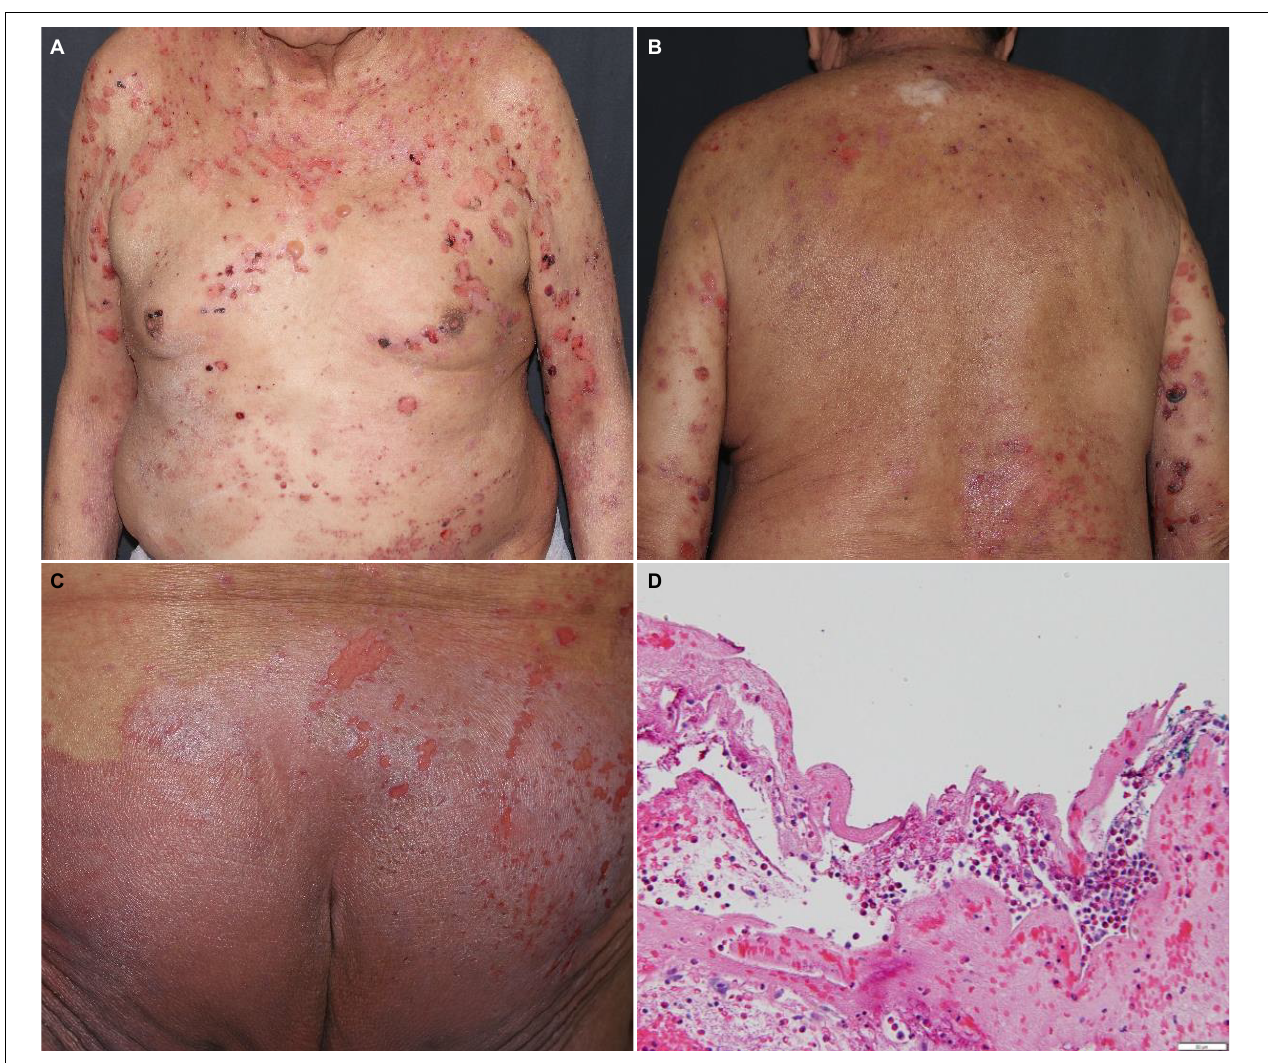
FIGURE 2 | Bullous pemphigoid with tense bullae and erosions on the (A) trunk, (B) back, and (C) buttocks. (D) Subepidermal vesicular dermatitis with abundant eosinophils and fibrin. Direct immunofluorescence studies revealed linear deposits of IgG, IgG4 and C3 at the basement membrane zone of the dermal-epidermal junction, focal deposits of fibrin in the reticular dermis and deposits of fibrin in the debris within the cleft.